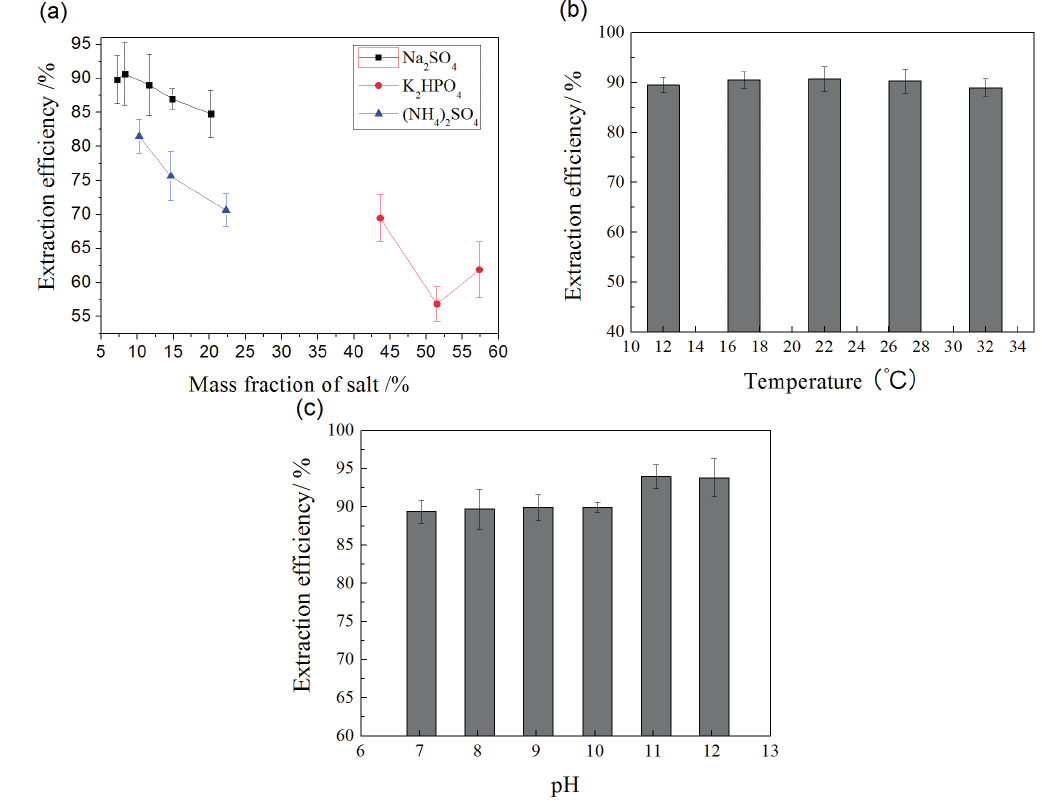
Figure 4. Effect of ( a ) salt; ( b ) temperature; and ( c ) pH on the extraction efficiency of SDG by